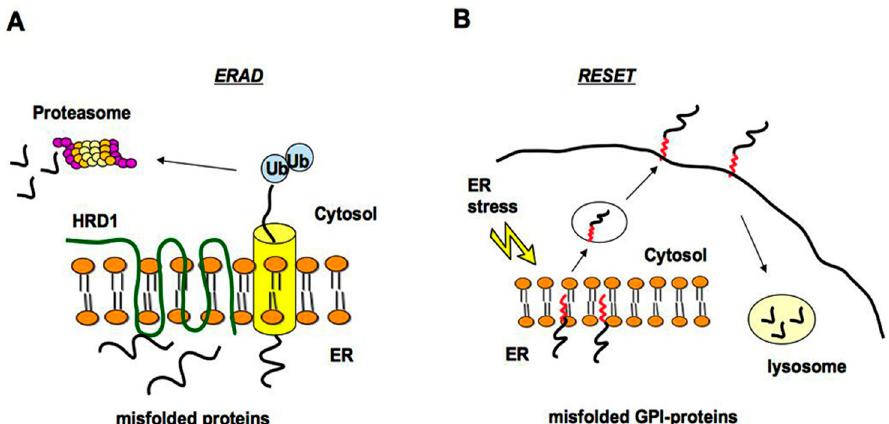
Figure 1. The ERAD and RESET pathway for degradation of misfolded proteins. ( A ) Misfolded proteins accumulated in the ER are retrotranslocated from the ER to the cytosol through the translocon (yellow). They are then polyubiquitinated and degraded by the proteasome system. HRD1 (an E3 ubiquitin-ligase) is localized into the ER membrane and mediates the transfer of ubiquitin from ubiquitin-conjugated enzyme E2 to substrates; ( B ) the ER-stress induced pathway called RESET regulates the degradation of misfolded GPI-anchored proteins, which dissociate from the resident ER chaperones (not illustrated) leaving the ER and reaching the cell surface transiently before lysosomal degradation.